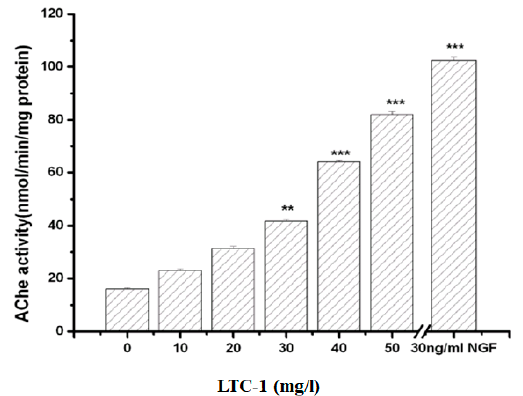
Figure 5. LTC-1 dose-dependently enhances the activity of acetylcholinesterase in cells. The mean SD is used to express the data. One-way ANOVA was used for statistical analysis, followed by Tukey’s multiple comparison test, ** p < 0.01, *** p < 0.001 vs. control.